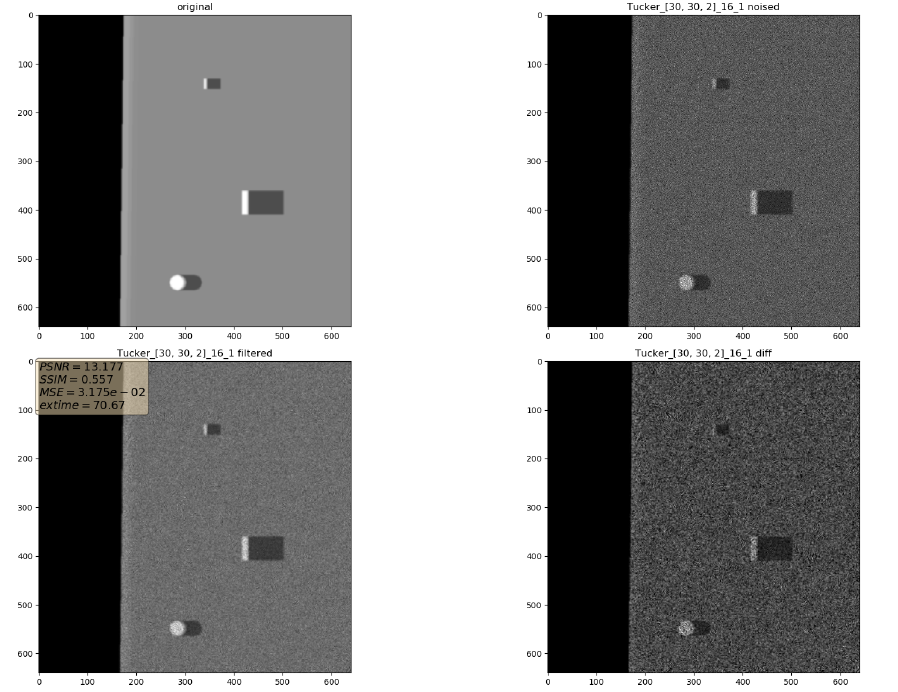
Figure 7. Filtering results for parameters: Tucker rank = [30, 30, 2], window size = 16, close neighbor distance = 1. Speckle noise σ 2 =